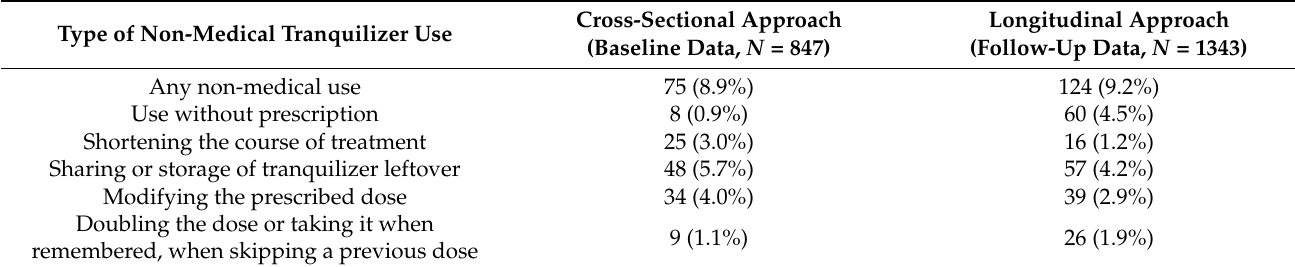
Table 2. Frequency of reported types of non-medical tranquilizer use at baseline and during the follow-up. Cross-Sectional Approach Longitudinal Approach Type of Non-Medical Tranquilizer Use Any non-medical use Use without prescription Shortening the course of treatment Sharing or storage of tranquilizer leftover Modifying the prescribed